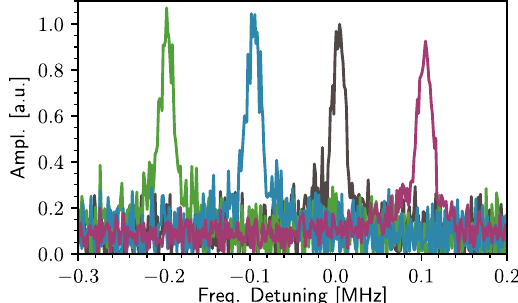
Fig. 4 Frequency tuning of the new light fi eld. This shows the spectrum of the cavity output fi eld as measured via a heterodyne setup for different input fi eld detunings. The starting point is the black curve with Δ 1 r = Δ 2 r = Δ = 0. The other curves are detuned by Δ 23 100 kHz for the violet, Δ 23 = 200 kHz for the green. The measured amplitude is normalized to the largest